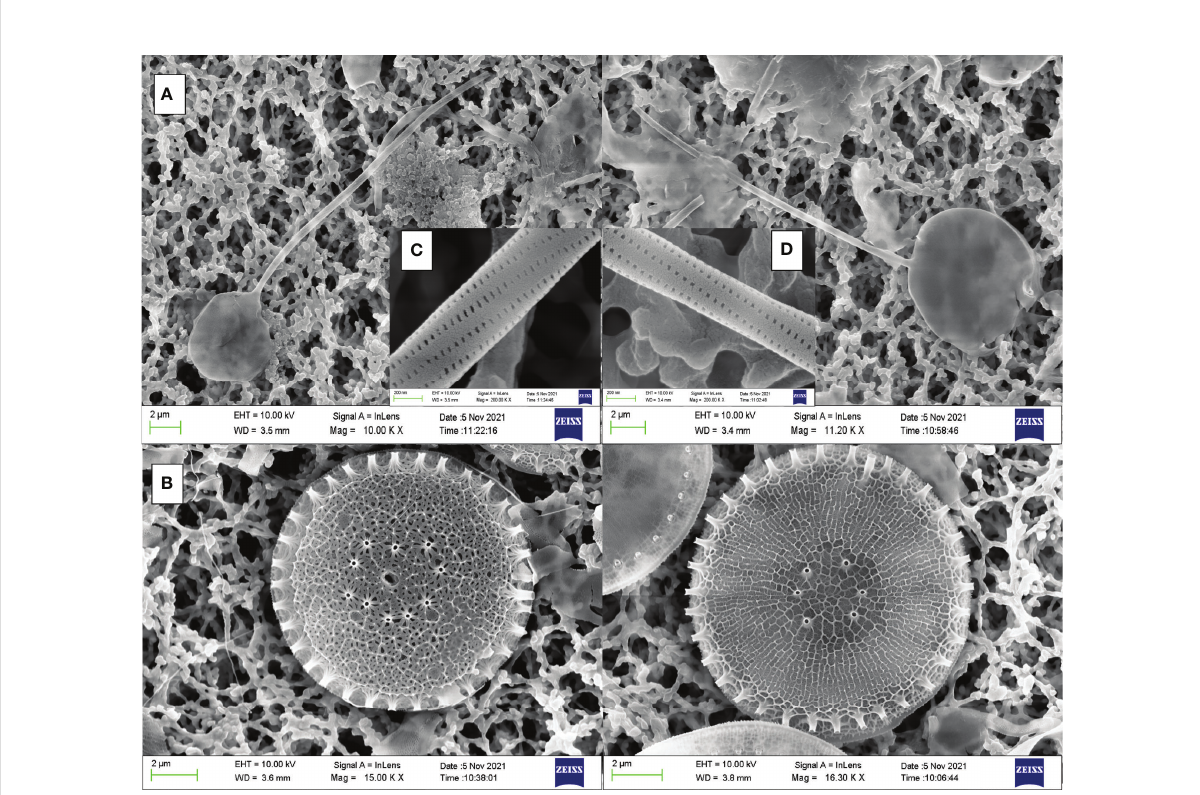
FIGURE 4 SEM images of frustules from C. muelleri (A) and C. weiss fl ogii (B) acclimated to 500 µM Si (left images) and 25 µM Si (right images). Details of C. muelleri setae at 500 µM Si (C) and 25 µM Si (D) are